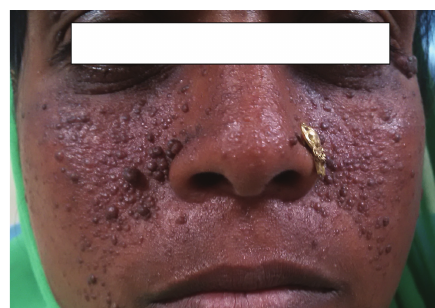
Figure 3: Multiple angiofibromas affecting the nasolabial folds and